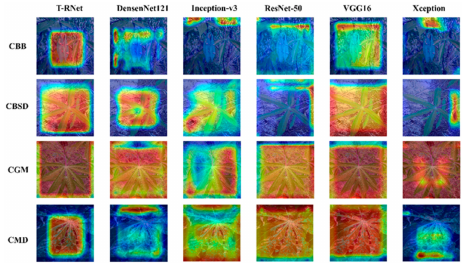
Figure 9. Grad_CAM attention maps for different models in different categories of